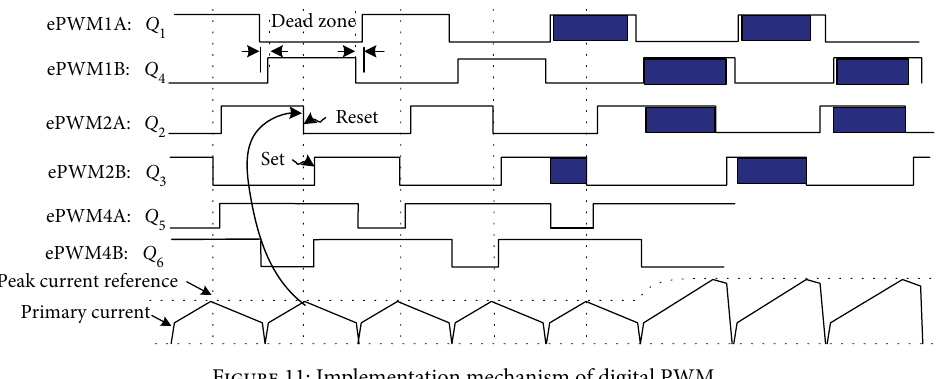
Figure 11: Implementation mechanism of digital PWM.